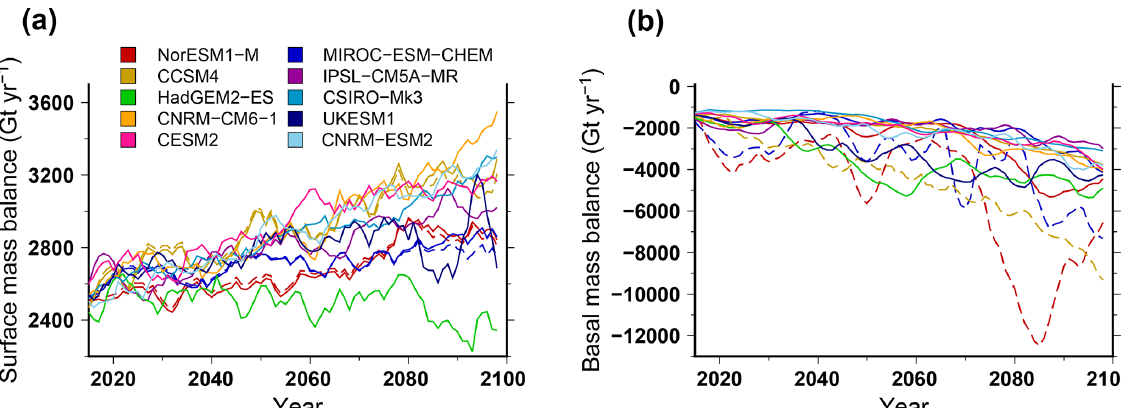
Figure 6. Simulated surface mass balance (a) and basal mass balance (b) , integrated over the ice sheet, for different CMIP5 and CMIP6 climate forcings using the RCP8.5 scenario and SSP585 scenario, respectively. The projection experiments shown in this figure use the medium oceanic sensitivity. The solid lines stand for the experiments that use the sub-shelf melting parameterisation calibrated against all the Antarctic data ( MeanAnt ), while the dashed lines are for the experiments that use a parameterisation calibrated against Pine Island area data only ( PIGL ). For this figure we use a 5-year running mean in order to smooth the interannual